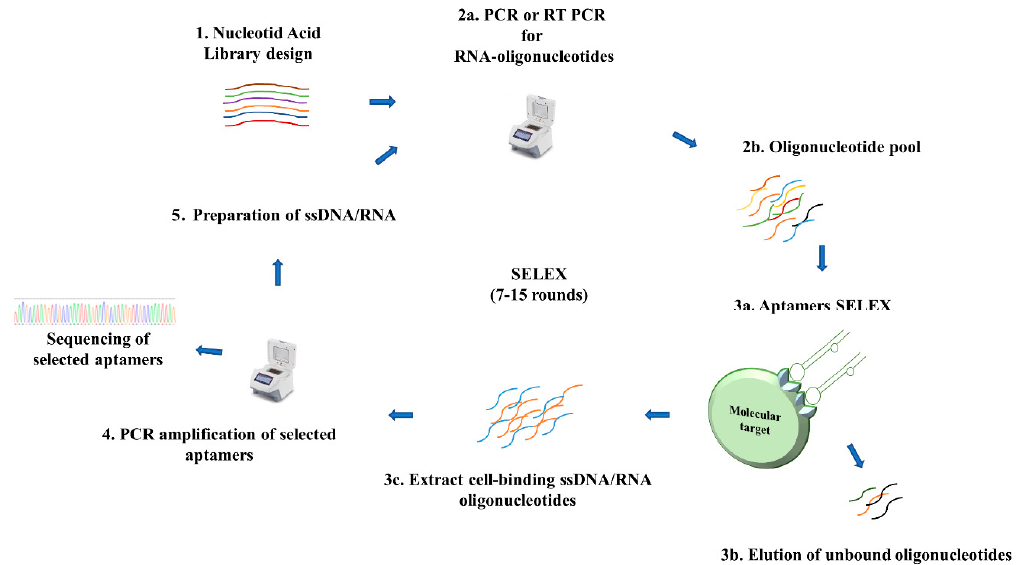
Figure 3. Aptamer design and selection (SELEX: Systematic evolution of ligands by exponential enrichment). The main steps of SELEX are: ( 1 ) Initial library design; ( 2 ) Preparation of the target molecule and selection (a. nucleotide synthesis by PCR; b. in this step, post synthesis chemical modifications are possible); ( 3 ) Separation of non-specific from specific-binding molecules (a. aptamer incubation with molecular target; b. elution of unbound oligonucleotides; c. extraction of specific-binding aptamers); ( 4 ) Amplification of selected sequences in PCR; and ( 5 ) Preparation of ssDNA / RNA.